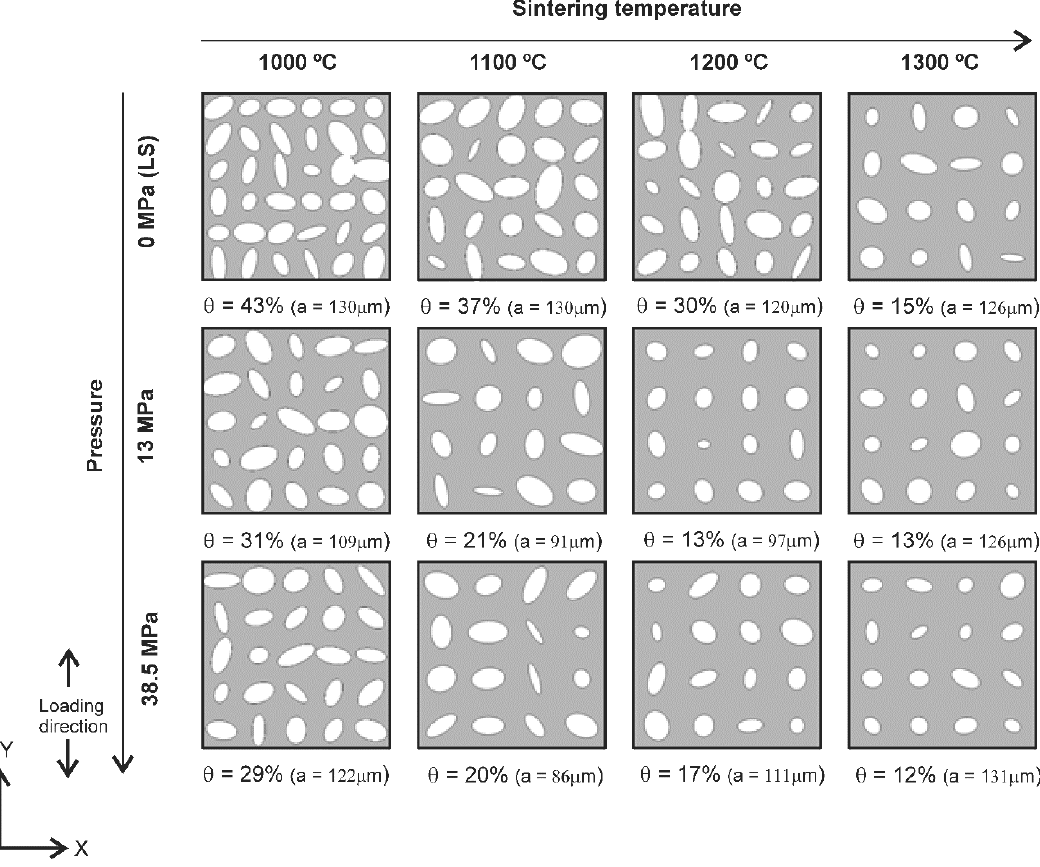
Figure 4. Representative geometries, for each porous material, with values of porosity ( θ ) and side length ( a ) included.